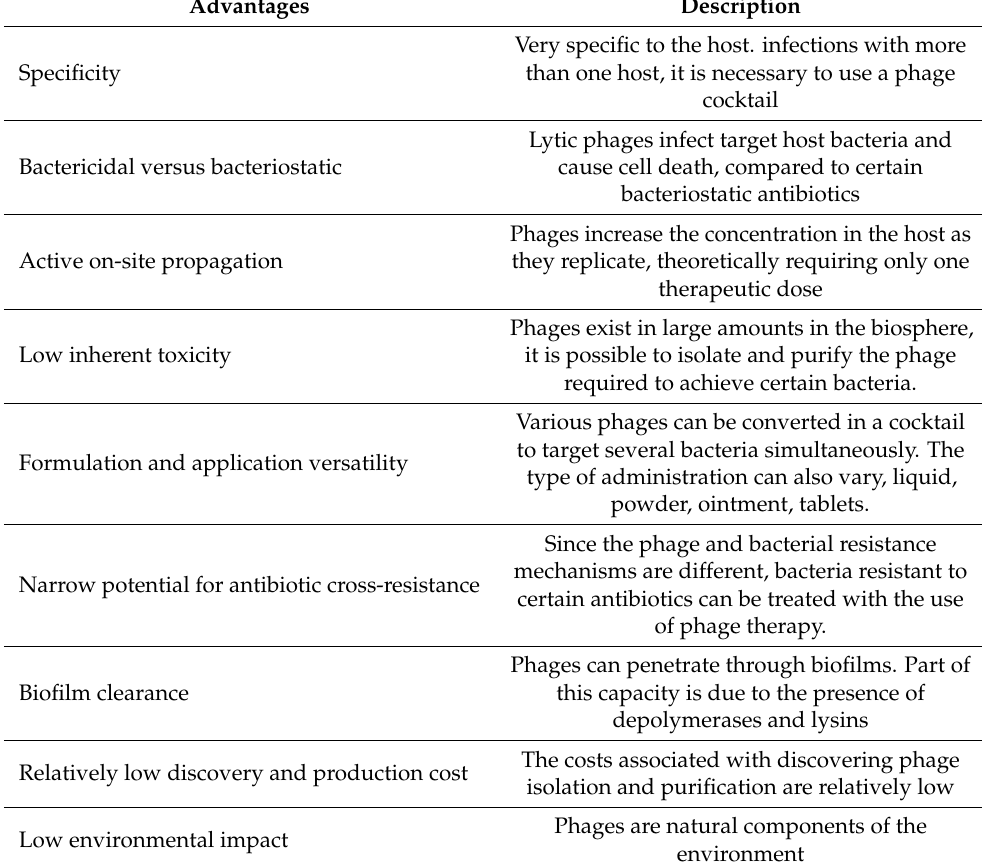
Table 2. Phages therapy